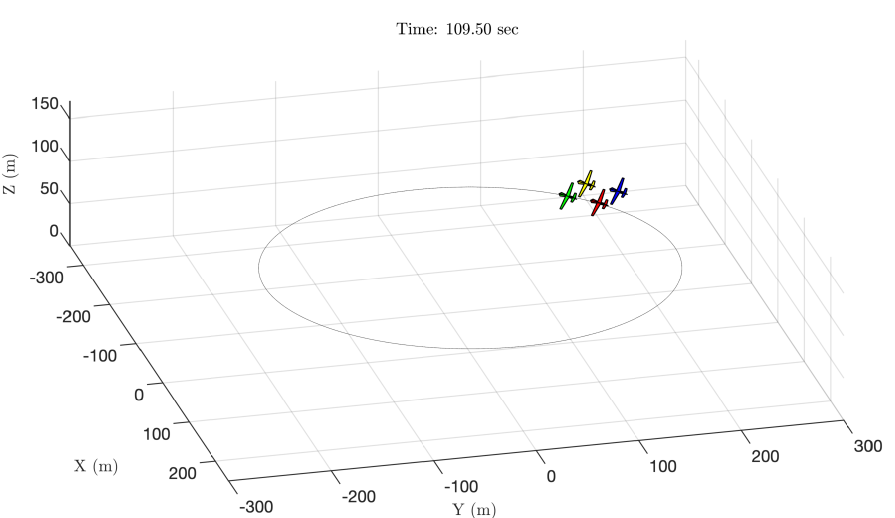
Figure 2. UAV trajectory for adaptive control case.